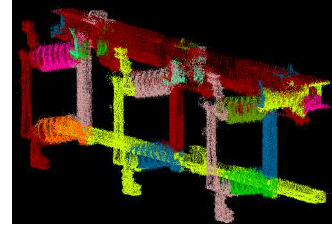
Figure 11. A closer view of segmented